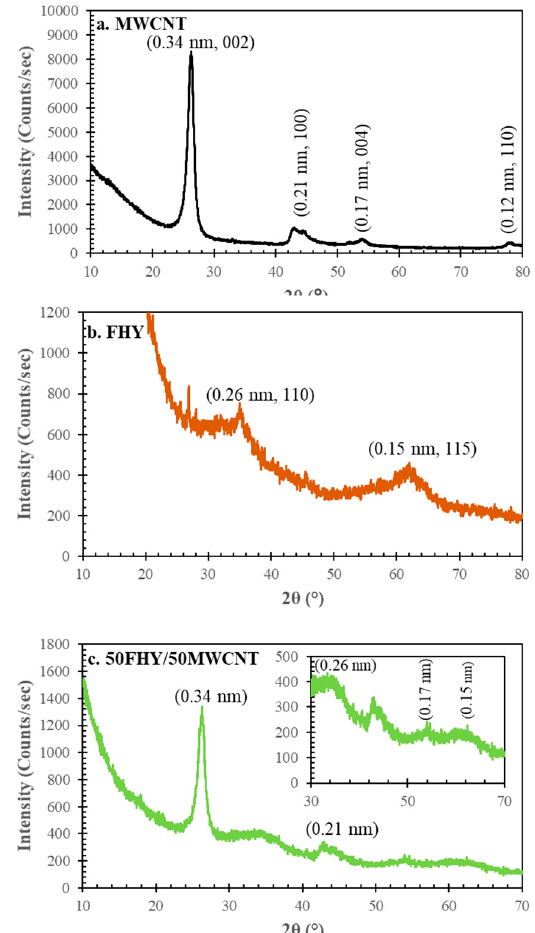
Figure 1. XRD patterns of ( a ) acid-treated multiwalled carbon nanotubes (MWCNT), ( b ) synthesized ferrihydrite (FHY) (blue), and ( c ) 50 FHY/50 MWCNT composite; the inset in ( c ) showed smaller intensity XRD peaks at smaller scale for better illustration. All XRD peaks in these figures were labeled with their corresponding 2 θ angles and d-spacings in nm, and their characterized XRD patterns from previous studies in ( a ) and ( b ).